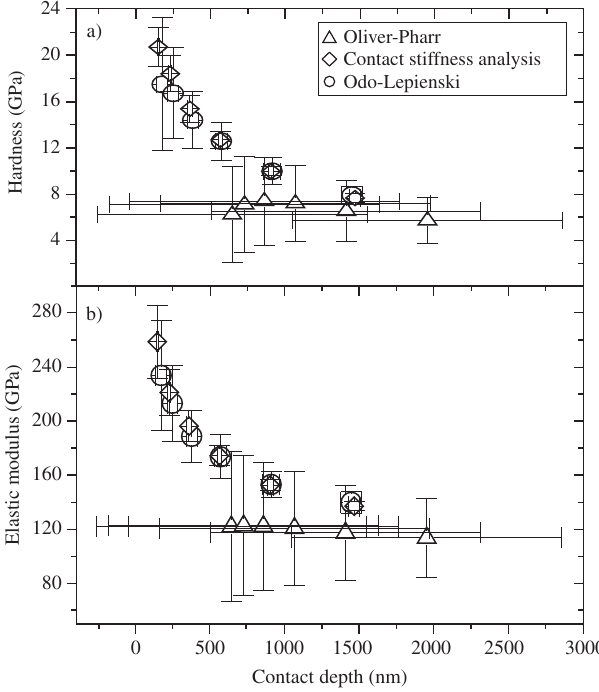
Figure 1. a) Hardness and b) elastic modulus vs. contact depth for titanium nitrided at 60%N / 40%H atmosphere and 800 °C: (  ) not corrected 2 2